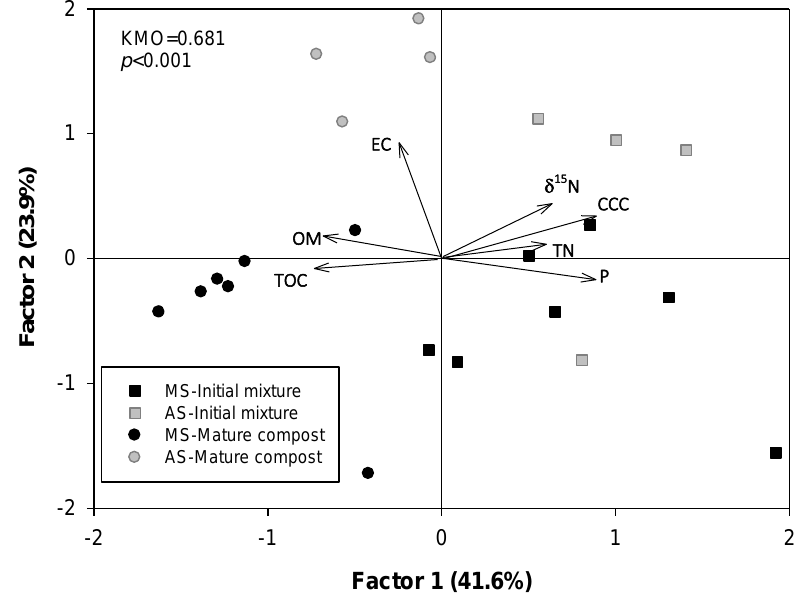
Figure 5. Plot of first and second factor extracted from factor analysis of initial composting mixtures and mature composts. Arrows correspond to the projection of the variables studied. EC: electrical conductivity; OM: organic matter; TOC: total organic carbon; CEC: cation exchange capacity; TN: total nitrogen; MS: sewage sludge; AS: agri-food sludge.